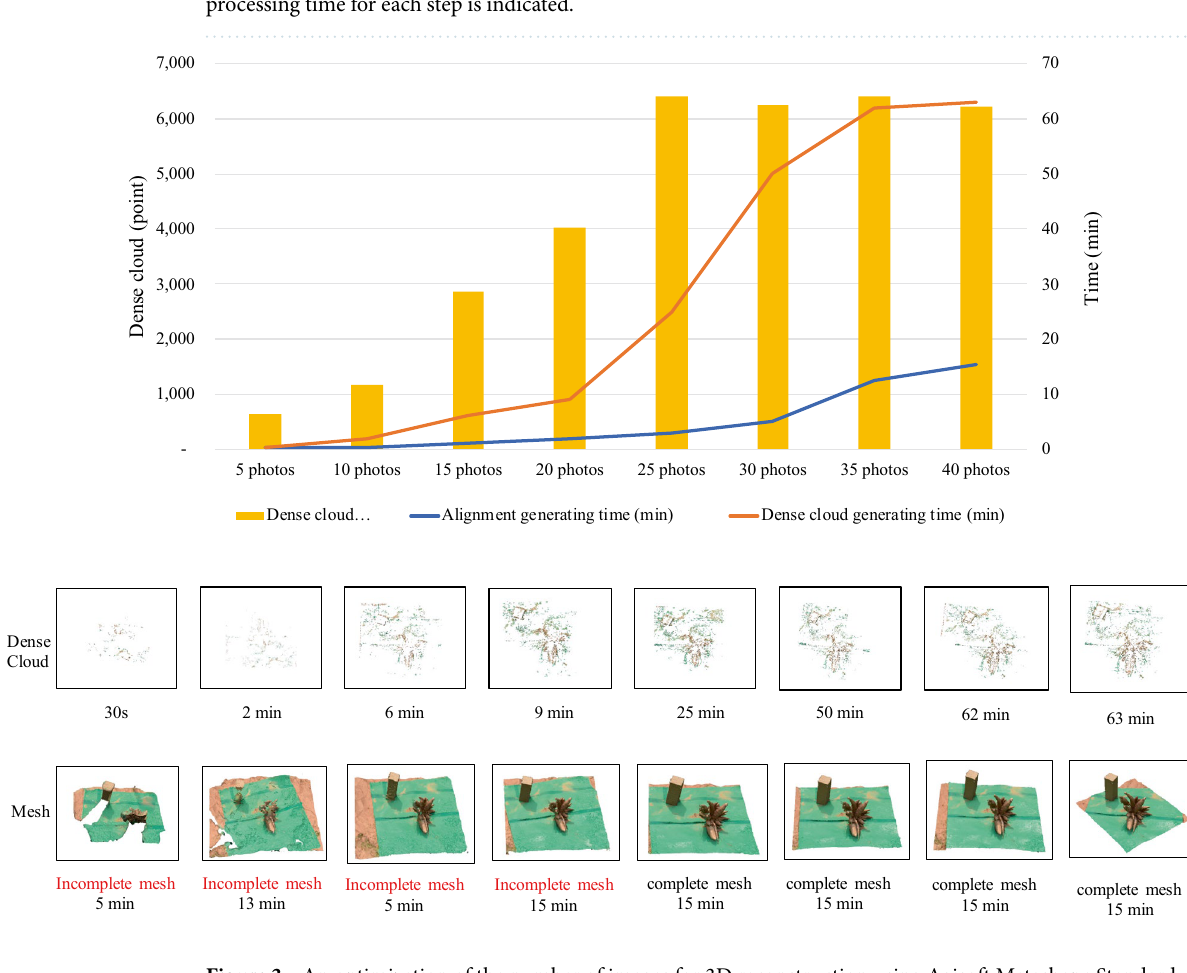
Figure 2. Workflows for 3D CRC reconstruction in Agisoft and 3D model analysis in Blender. An approximate processing time for each step is indicated.